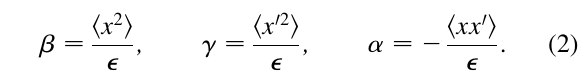
ffiffiffiffiffiffiffiffiffiffiffiffi p 8 (cid:6)=e 4 Þ . For simplicity we will use r a 0 = ð k where K ¼ p s ¼ (cid:6) in the following, such that maximum accelerat- (cid:5) k p l